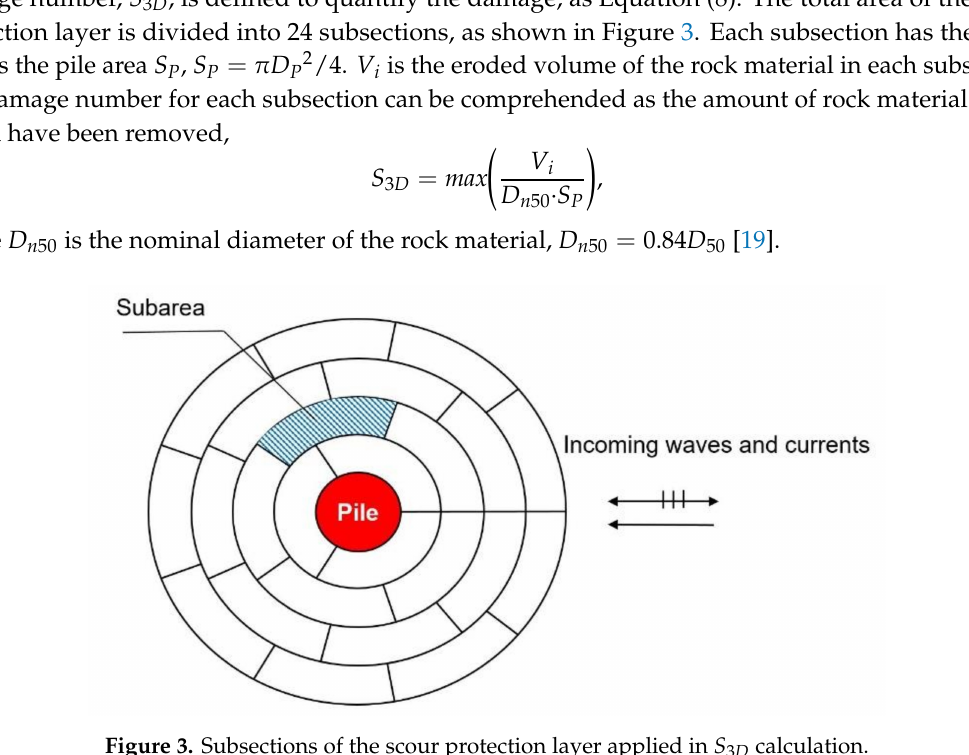
Figure 3. Subsections of the scour protection layer applied in S 3 D